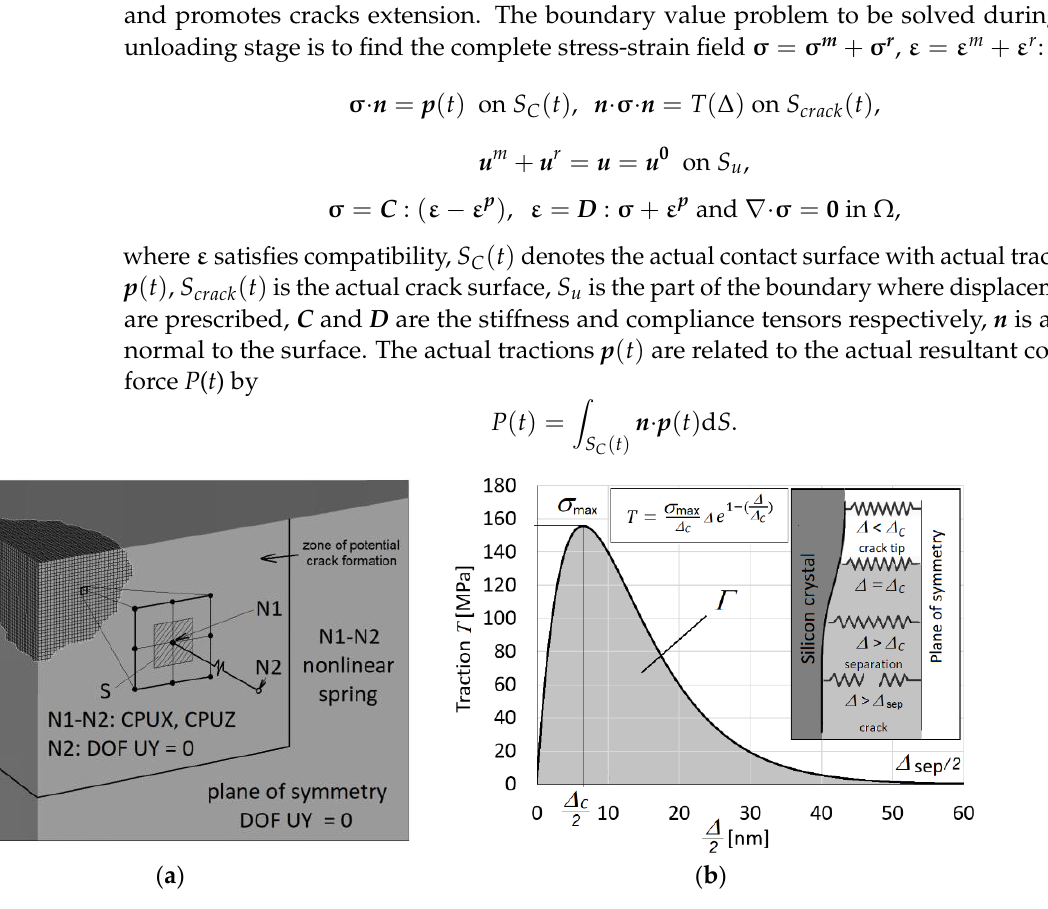
Figure 4. Cohesive zone model ( a ) definition and boundary conditions, ( b ) the traction-crack opening length relationship.